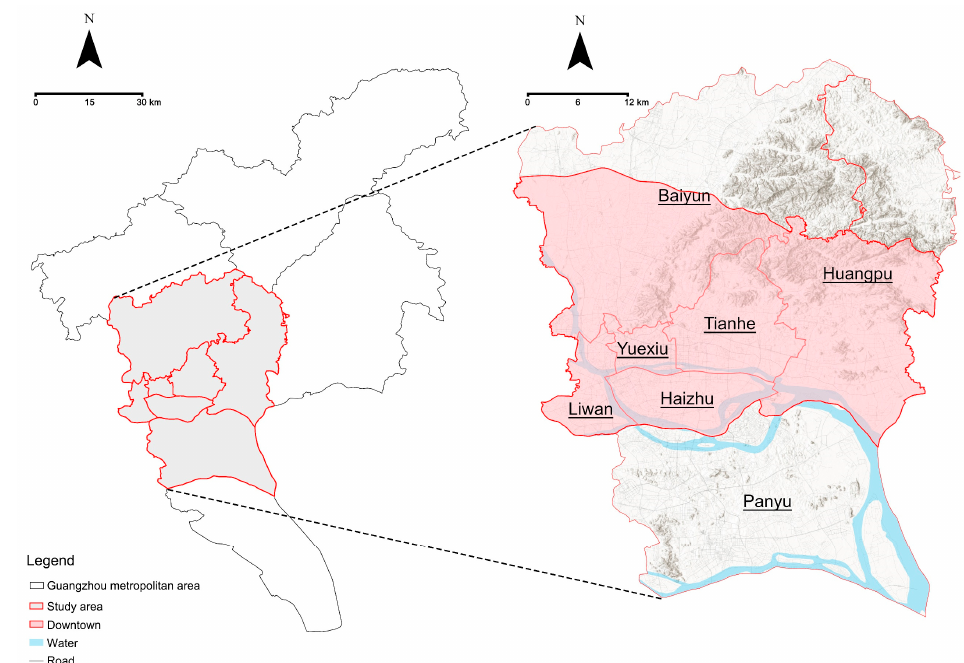
Figure 1. Study area. Map data sources: Esri, Airbus DS, USGS, NGA, NASA, CGIAR, N Robinson, NCEAS, NLS, OS, NMA, Geodatastyrelsen, Rijkswaterstaat, GSA, Geoland, FEMA, Intermap, and the GIS user community.